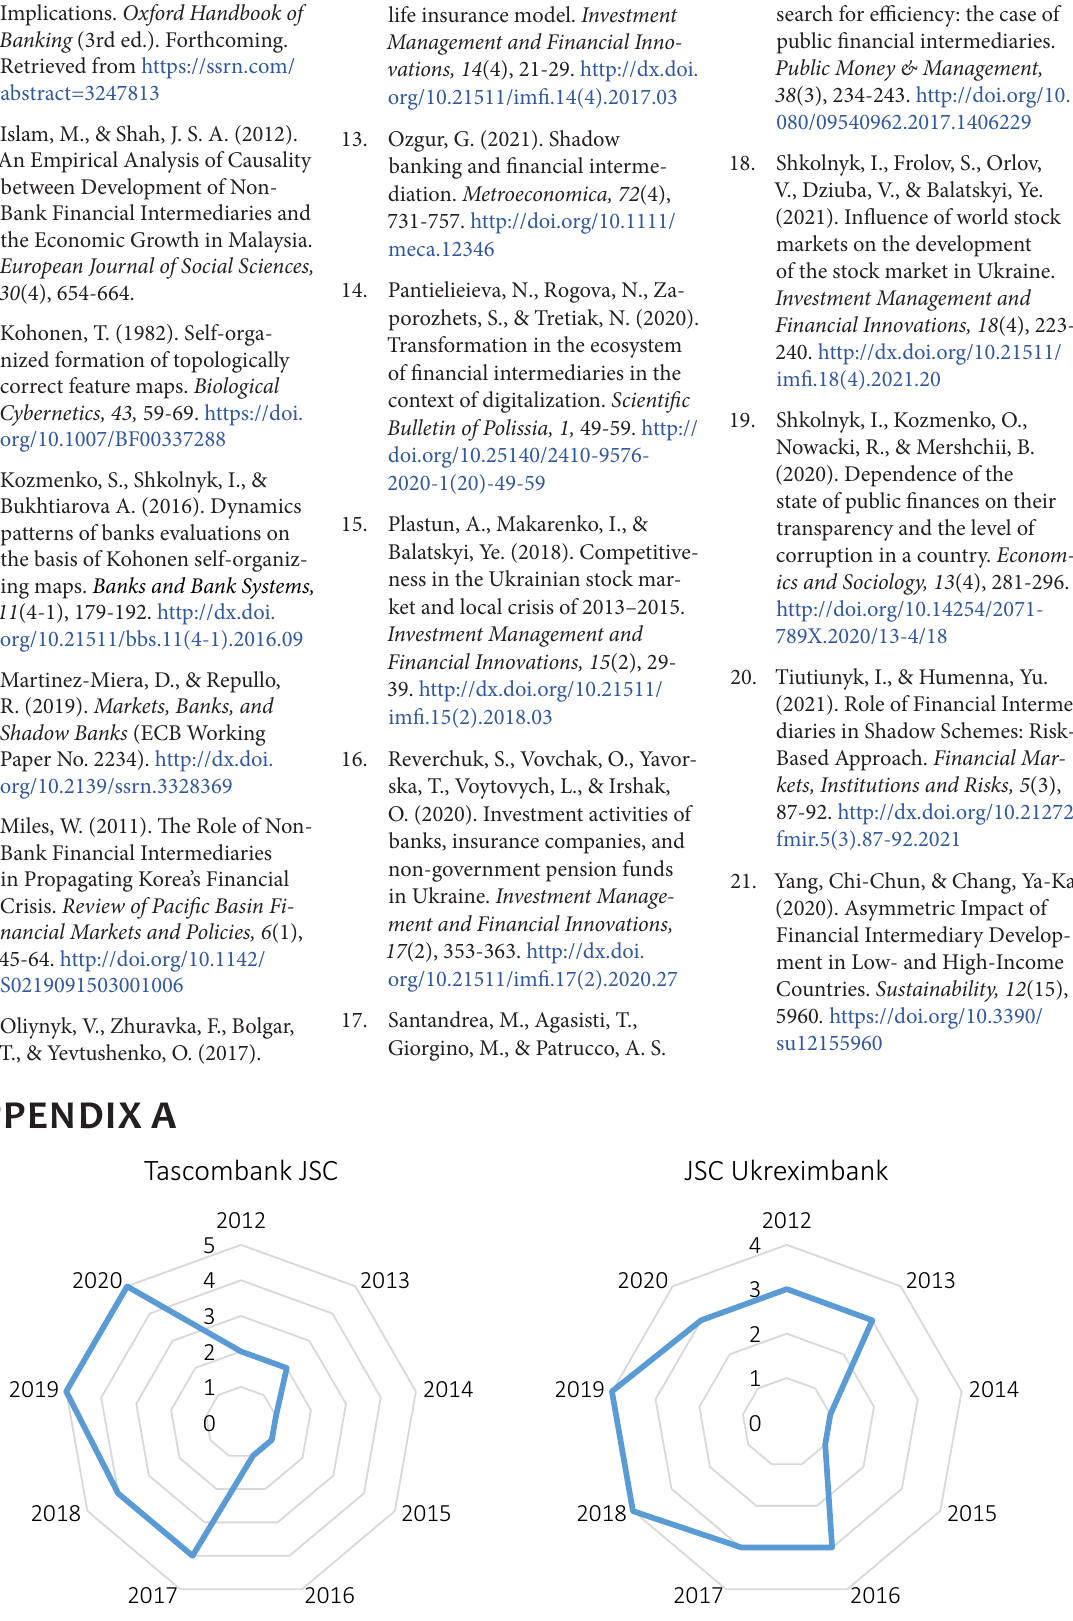
Figure A1. Development patterns of financial intermediaries’